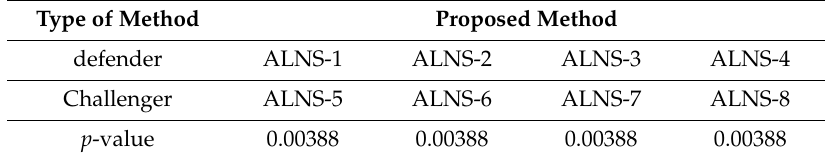
Table 13. p value of comparison the ALNS with ACO-without